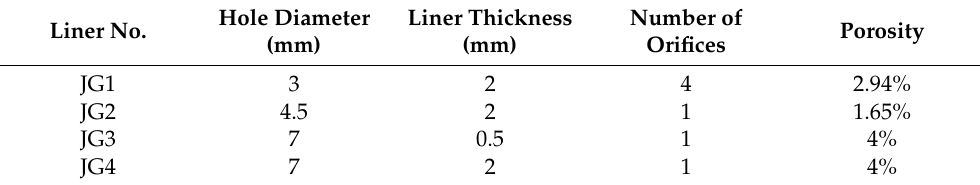
Figure 11. Numerical and experimental comparison of normalized specific acoustic impedance as a function of the grazing flow Mach number for ( a ) liner JG1, ( b ) liner JG2, ( c ) liner JG3 and ( d ) liner JG4 [23].